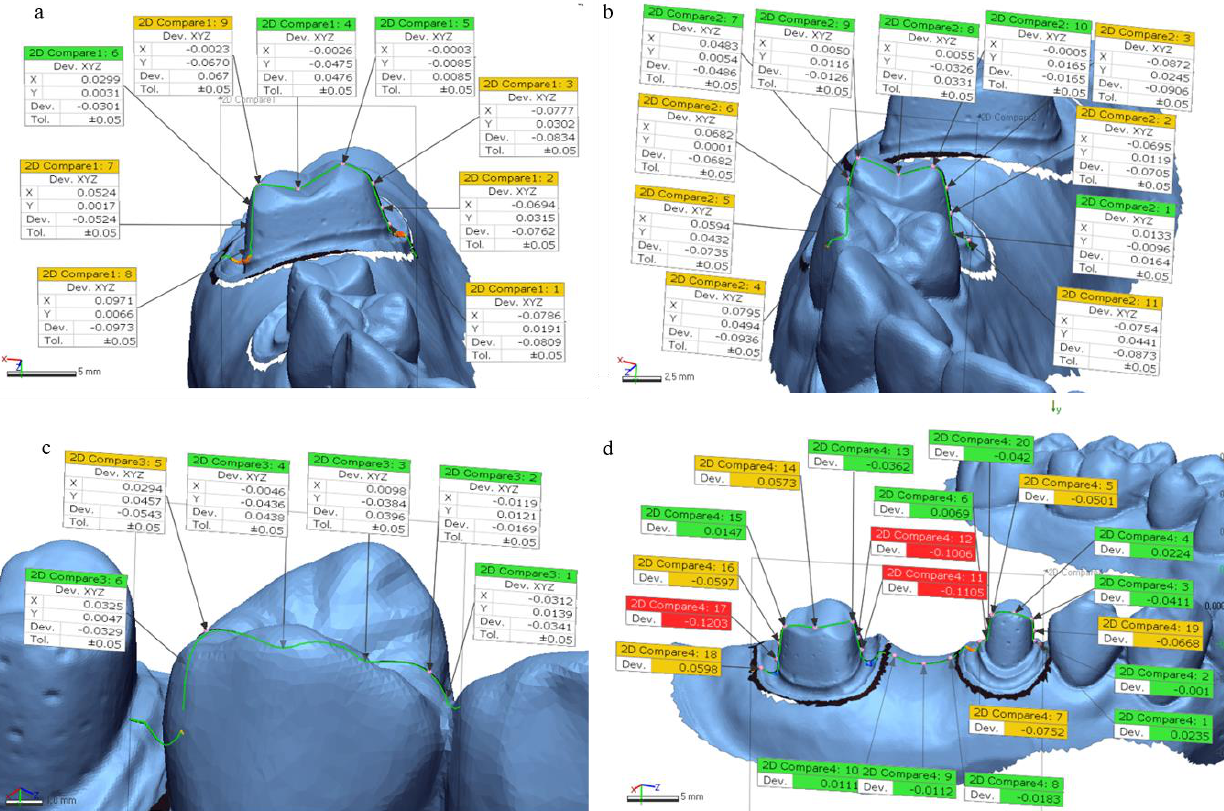
Figure 3. Four landmarks for measurement of trueness on 3D-printed models with the reference file. ( a ) molar tooth at buccolingual section. ( b ) Premolar tooth at buccolingual section. ( c ) Proximal contact to approximate tooth. ( d ) Molar and premolar teeth at mesiodistal section.